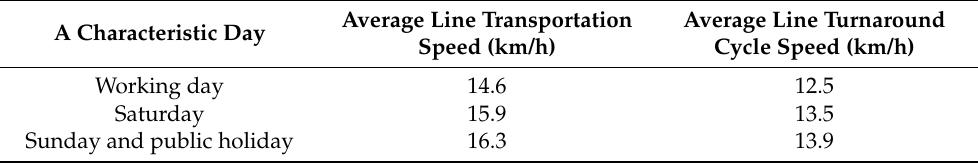
Table 2. Line speed indicators for tram lines during autumn, winter, and spring